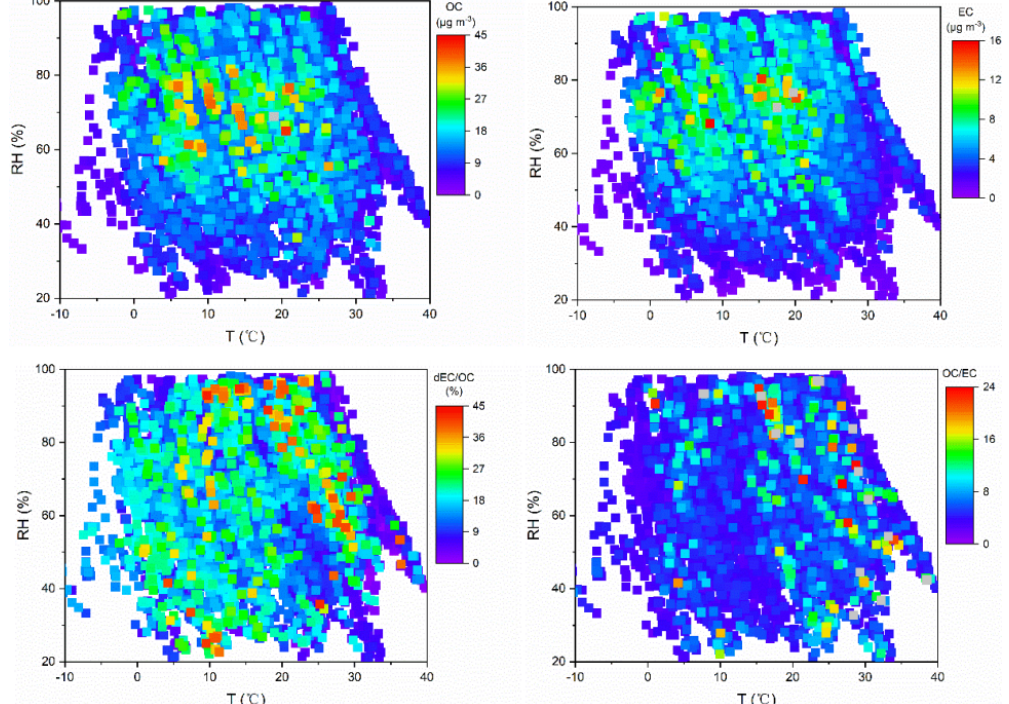
Figure 7. RH /T dependence of OC and EC and dEC / OC and OC / EC ratios during the study period.